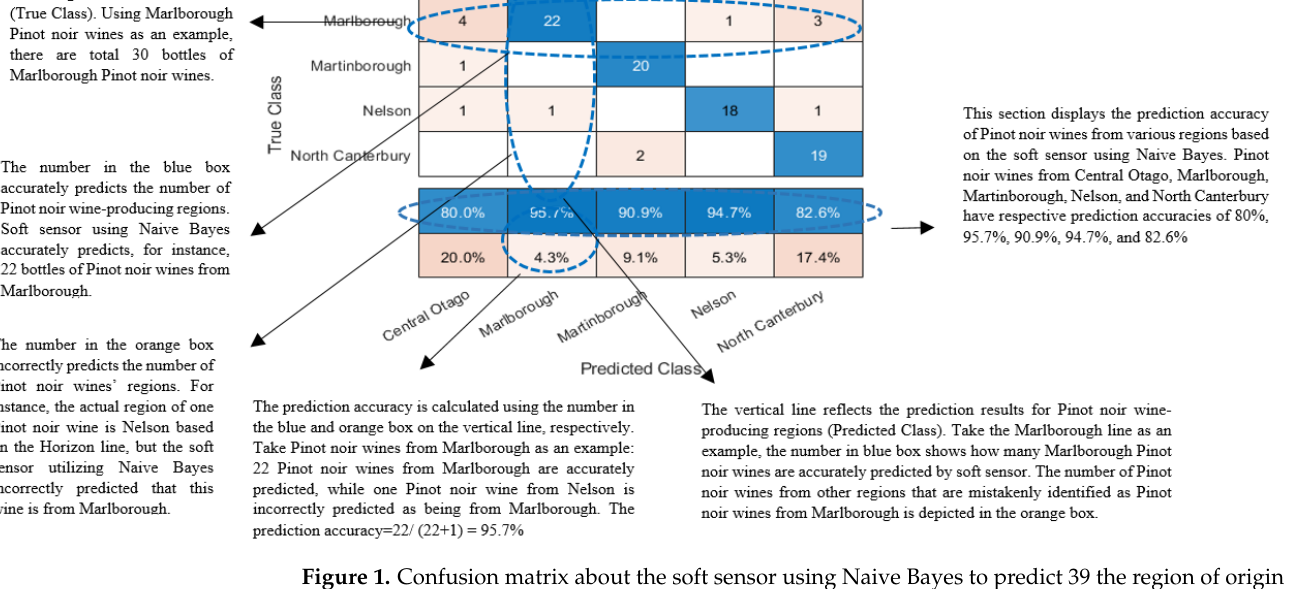
Figure 1. Confusion matrix about the soft sensor using Naive Bayes to predict 39 the region of origin of New Zealand Pinot noir wines. Dotted circles in the confusion matrix were used to help readers to understand what is True class, Predicted class, the meaning of the blue box and the orange box, and how the prediction accuracies are obtained.